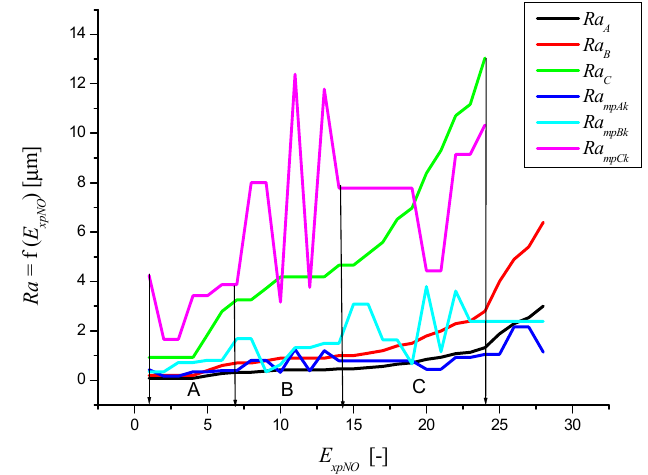
Figure 7. Surface roughness after machining, measured and discrete (analytical) roughness. Section A ( E xpNO 1–7) insufficient roughness for the desired adhesion, Section B ( E xpNO 7–14) very good roughness for the desired adhesion, Section C ( E xpNO 14–24) sufficient roughness for the desired adhesion.